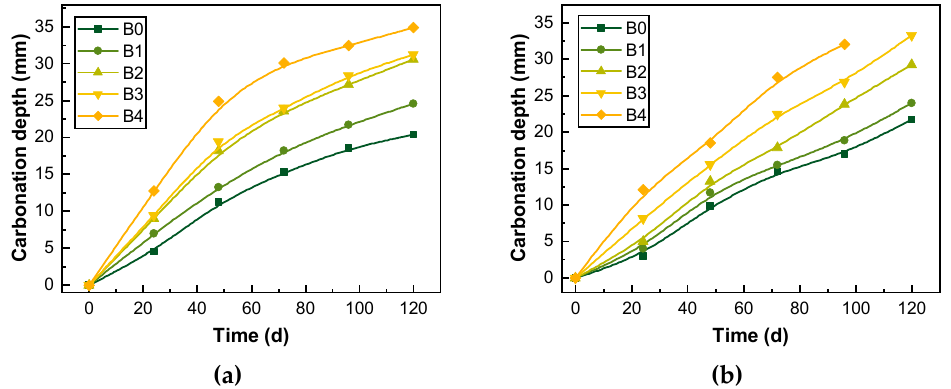
Figure 10. The complete carbonation depths of concrete beams B0–B4: ( a ) phenolphthalein titration; ( b ) pH meter method.